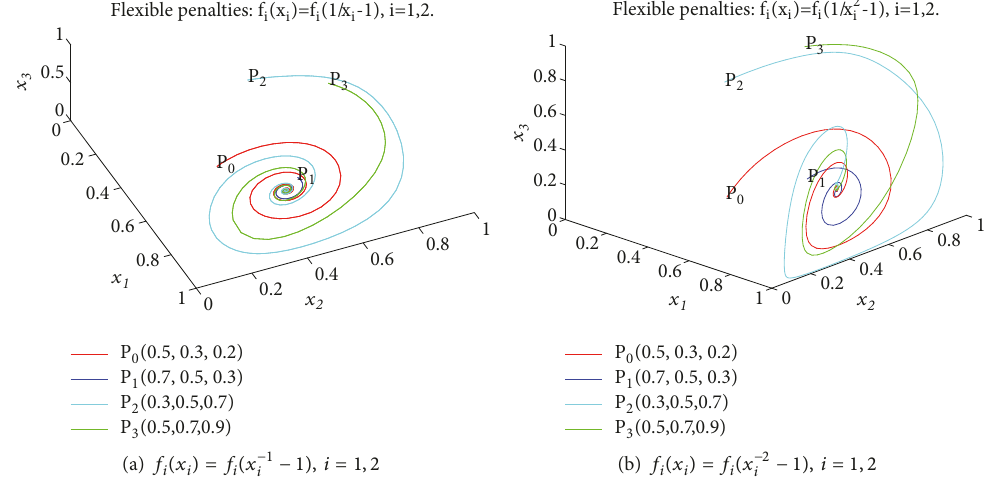
Figure 7: Phase diagram of dynamical system of tripartite game with flexible penalty